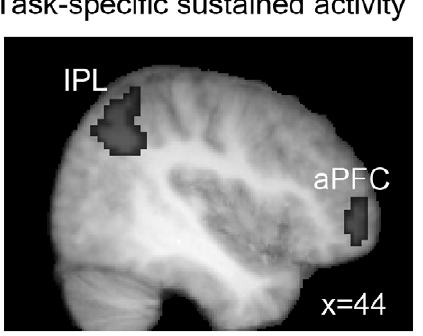
Figure 5. Task-dependent effects during the response epoch. Greater sustained activations during the response epoch of the SST in comparison to the NST are shown on a sagittal slice (p , 0.05, FDR corrected). Abbreviations: aPFC: anterior prefrontal cortex; IPL: inferior parietal lobule.